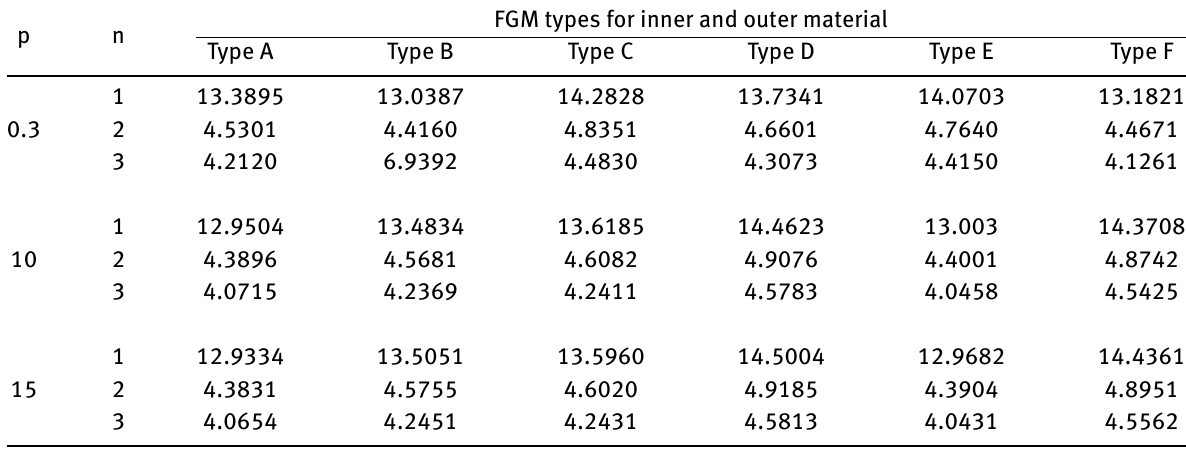
Table 4: Frequency values of simply supported (S-S) FGM circular cylindrical shell with different types and modes